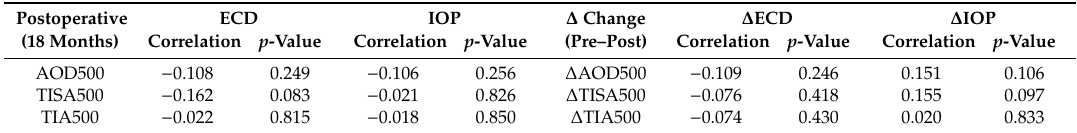
Figure 4. Time course of trabecular iris angle at 500 µm (TIA500) after implantable collamer lens (ICL) implantation. The TIA500 was significantly decreased 1 day postoperatively and subsequently stabilized over time. Bar represents standard deviation. Table 2. The relationships of the angle opening parameters with the endothelial cell density (ECD) and the intraocular pressure